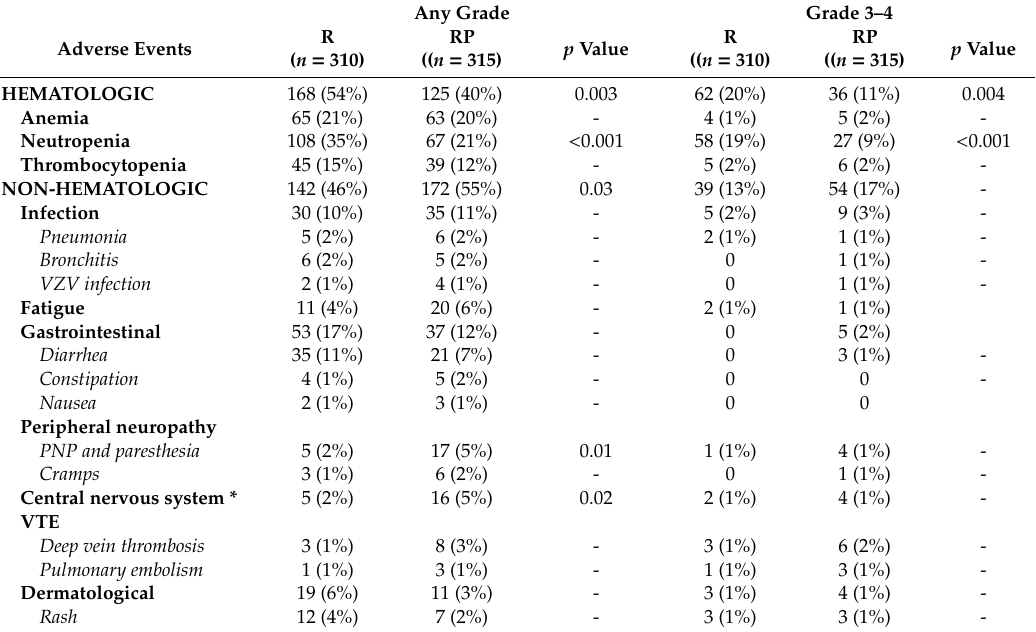
Table 3. Main treatment-related adverse events during maintenance. Number (%) of patients with at least one adverse event Any